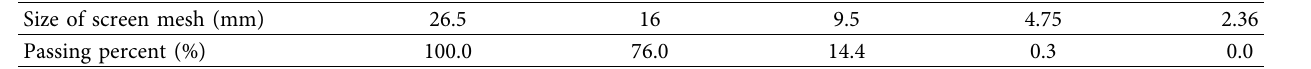
Table 3: Particle size distribution of coarse